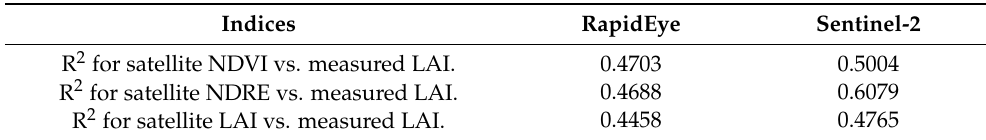
Table 1. Comparing Pearson correlation coefficients (R 2 ) for measured LAI and satellite NDVI, NDRE and LAI for RapidEye and Sentinel-2 images and field trips in July